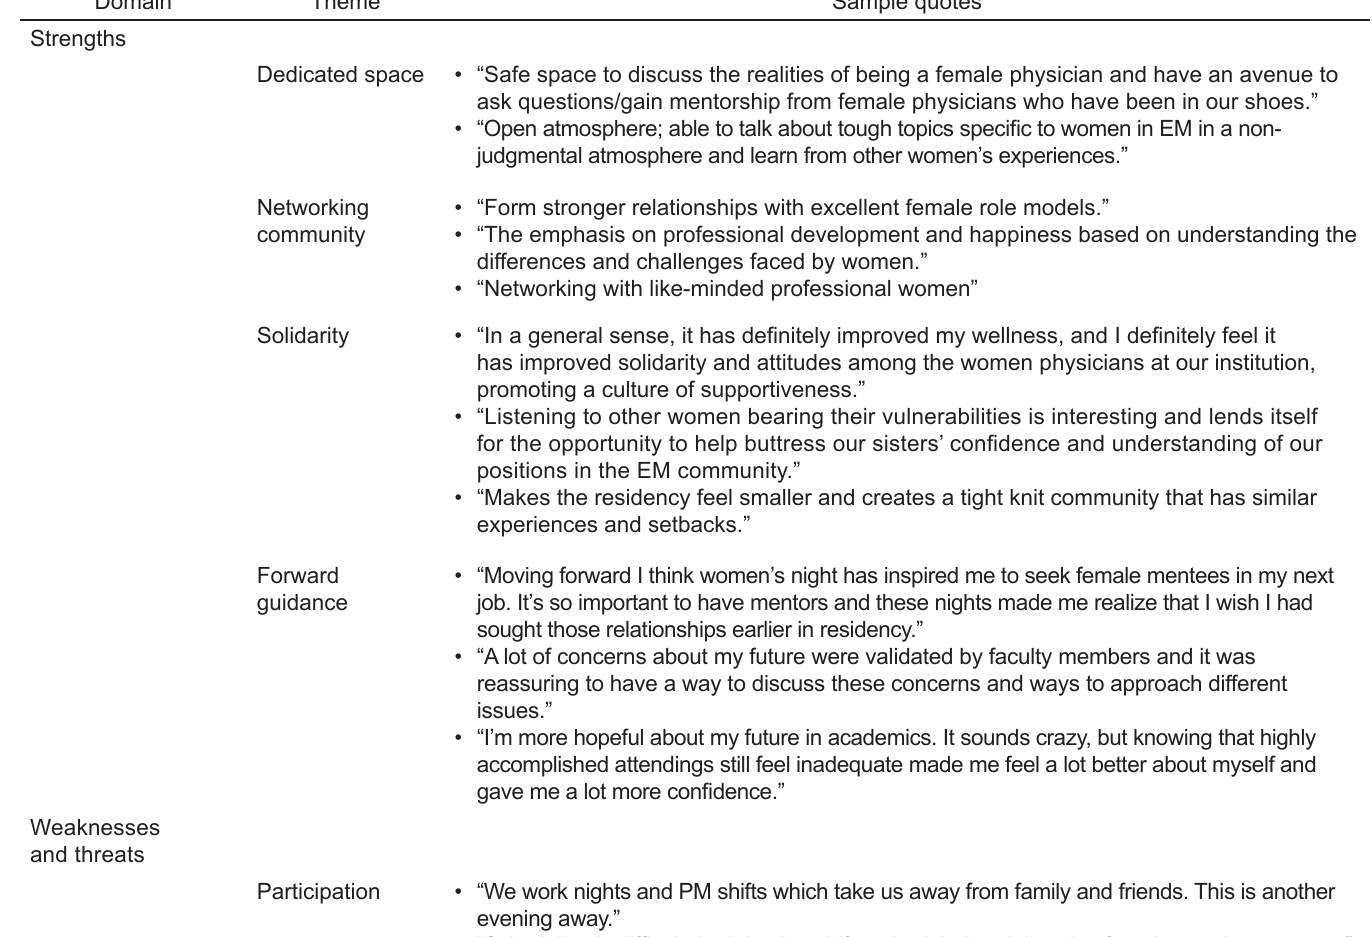
Table. Themes identified in participant responses with representative